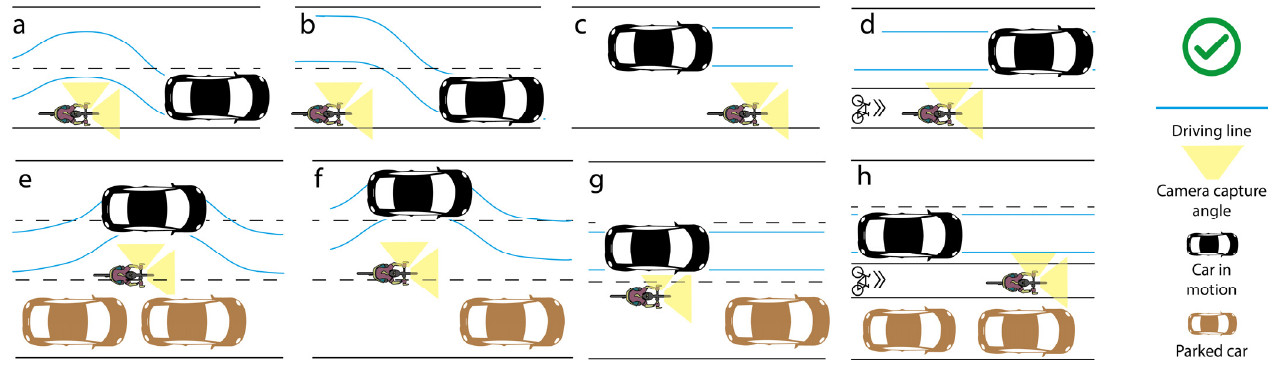
Figure 3. Cases considered to be overtakings. ( a ) and ( b ) overtaking by switching lanes; ( c ) overtaking in the absence of a dividing line; ( d ) overtaking along a bike lane; ( e – h ) overtaking in the presence of parked vehicles.